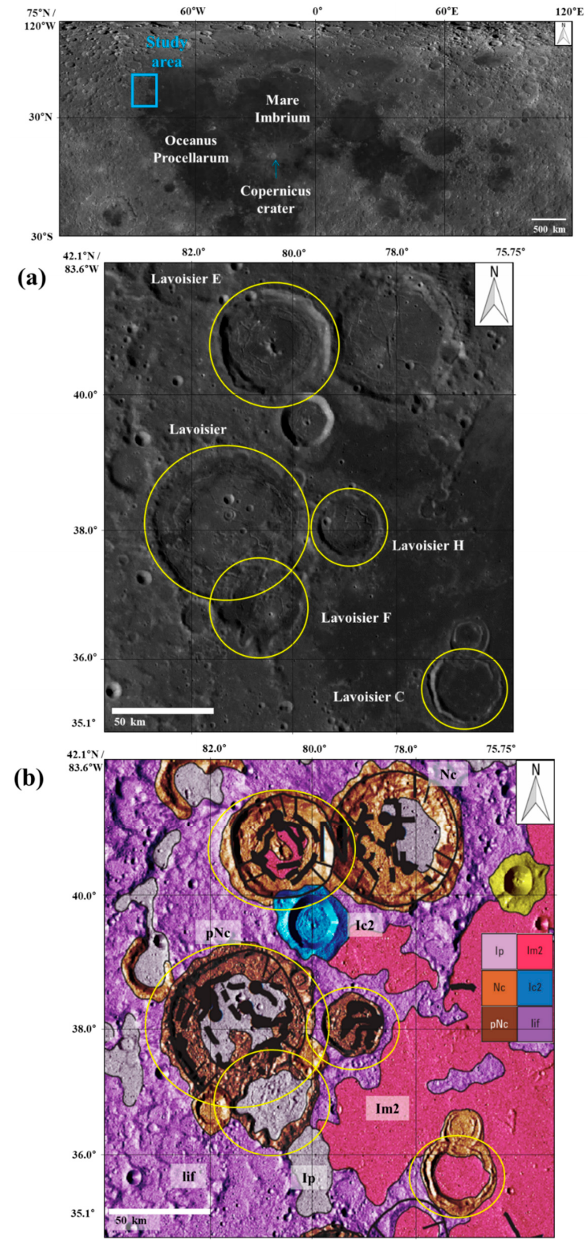
Figure 1. ( a ) Wide-angle camera (WAC) base map mosaic ( a ) showing the distribution of FFCs and mare basalts in the research area. The blue boxed area (study area, upper ( a )) is marked in the northwestern edge of Oceanus Procellarum. The yellow circles have the FFCs that include the mare basalts (the data were downloaded from https://quickmap.lroc.asu.edu, accessed on 1 April 2022). The geological map ( b ) referred from the United States Geological Survey (USGS) shows the materials for each crater; The Lavoisier E-Nc, Im2, Lavoisier and Lavoisier F-pNc, Nc, Ip, Lavoisier H-pNc, Lavoisier C-Nc, Im2. The explanation about the materials follow as the USGS geological units; pre-Nectarian crater (pNc, pre-Nectarian: − 4.5 to − 3.9 Ga), Nectarian crater (Nc, Nectarian: − 3.9 to − 3.8 Ga), Imbrian Plains (Ip, impact crater ejecta, Imbrian: − 3.8 to − 3.2 Ga), Imbrian mare, upper (Im2, upper mare material, basaltic lava flows), Imbrian Crater, Upper (Ic2, materials of the Orientale group), Imbrian Imbrium Fra Mauro Formation (Iif, surface texture locally hummocky.). We